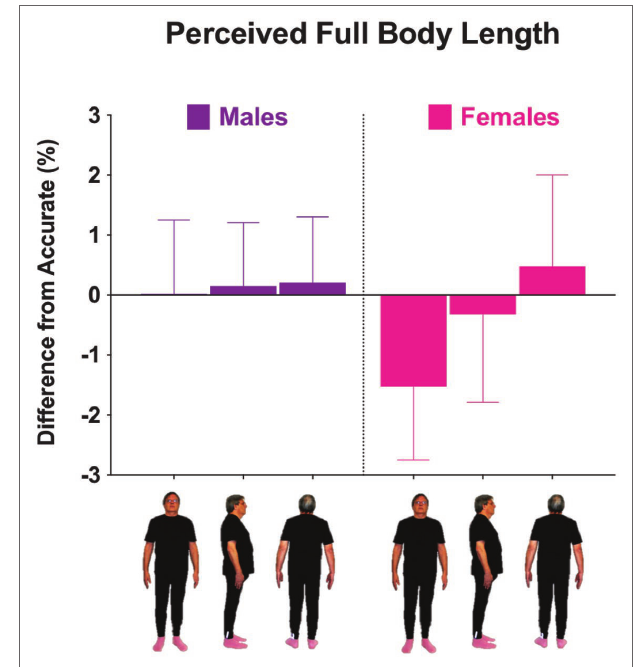
FIGURE 4 | Mean differences from accurate for males ( left panel ) and females ( right panel ) when body length (height) was distorted for each viewpoint. Positive and negative scores represent overestimation and underestimation, respectively. Error bars represent ±1